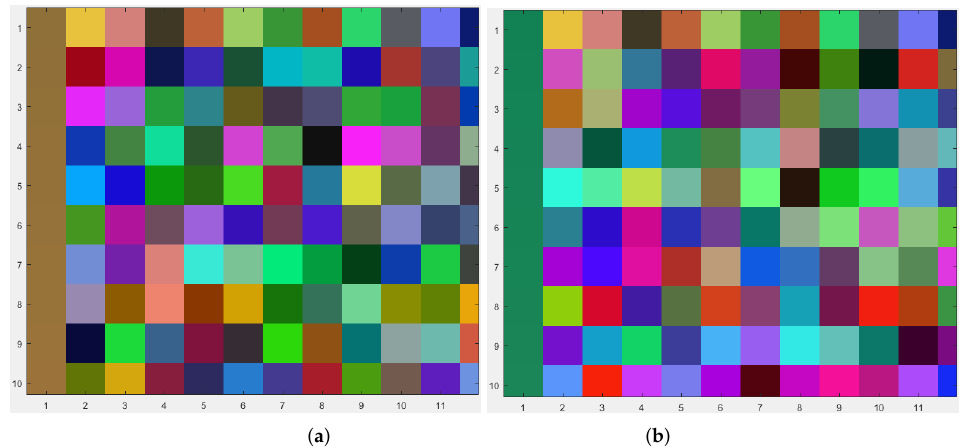
Figure 9. Zoom on the first 10 rows and 11 columns of a black picture with deterministic noise added. ( a ) Using the parameters p 1 = 65, p 2 = 31, and p 3 = 18. ( b ) Using the parameters p 1 = 210, p 2 = 133, and p 3 =